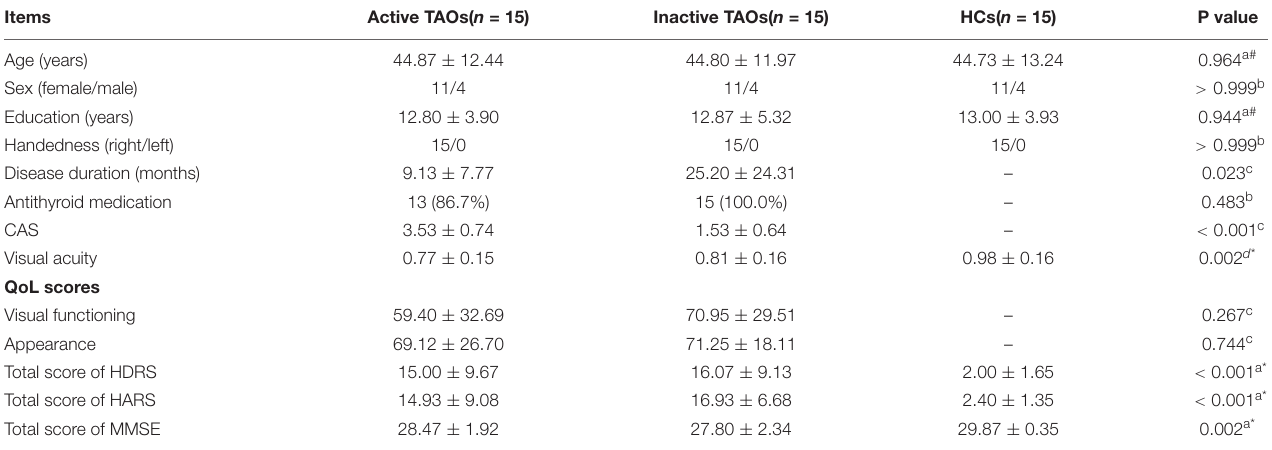
TABLE 1 | Demographic and clinical characteristics of the active TAO group, inactive TAO group, and HCs. Items Active TAOs( n = 15) Inactive TAOs( n = 15) HCs( n = 15)